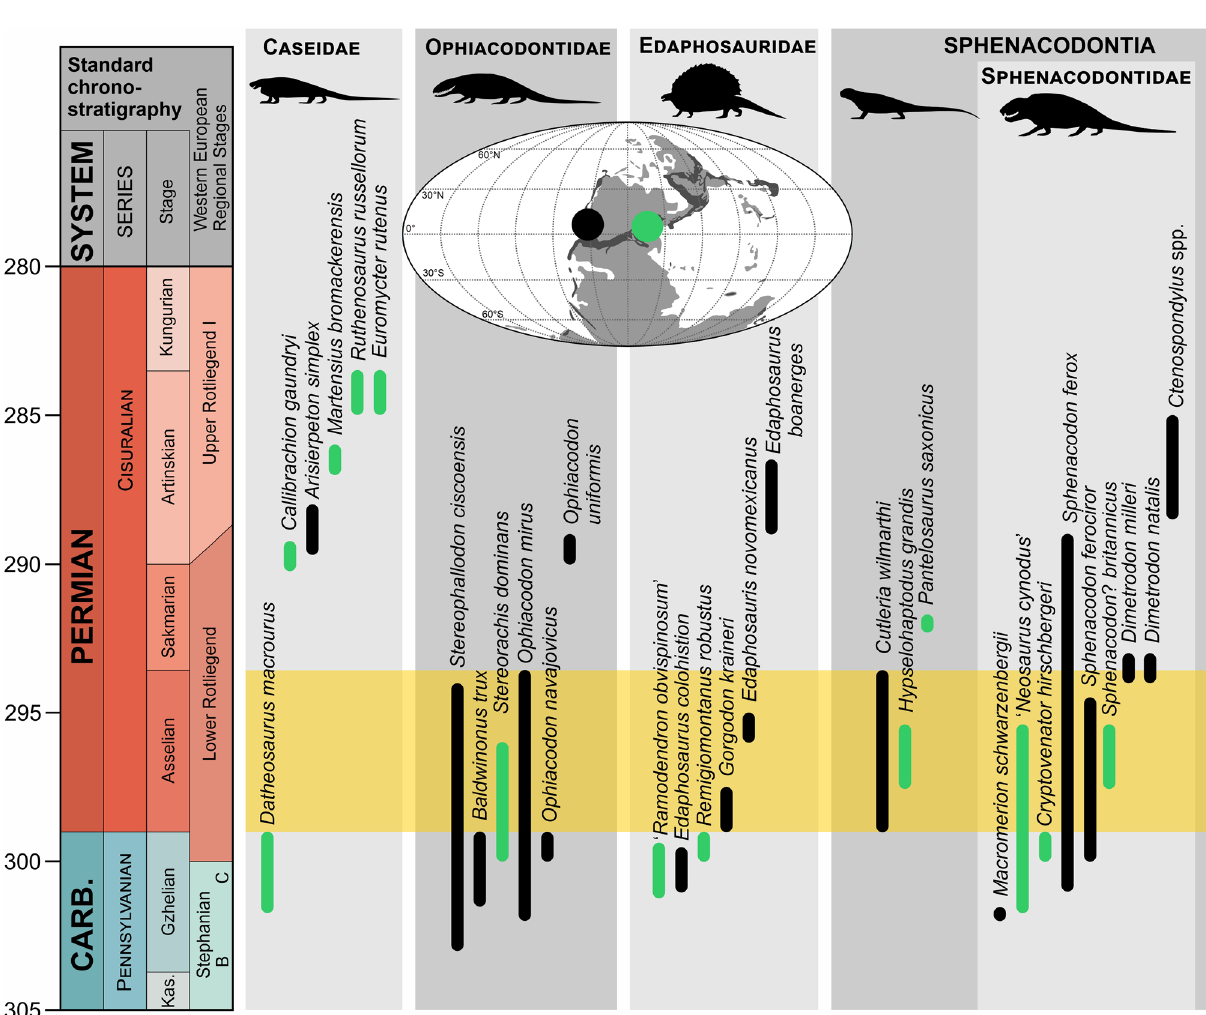
which would represent the potential source of prey, no body fossils of sphenacodontians have been recorded from